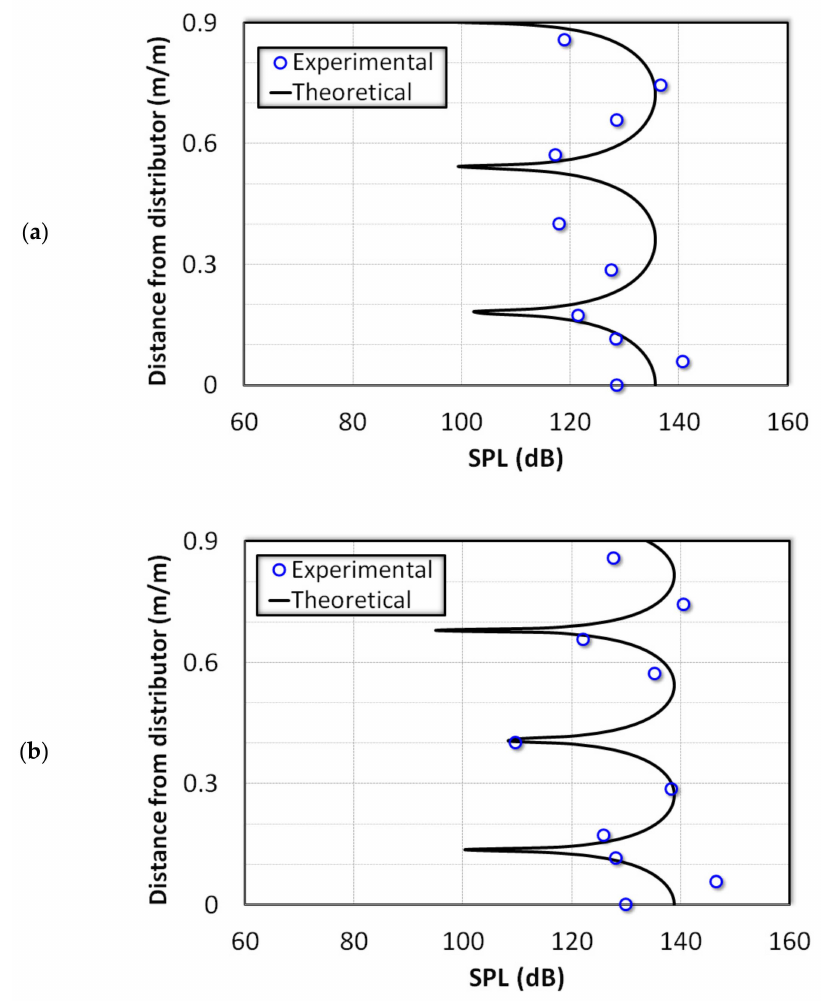
Figure 7. Comparison of model predictions with experimental data in an empty column subjected to sound waves of frequencies ( a ) 240 Hz and ( b ) 360